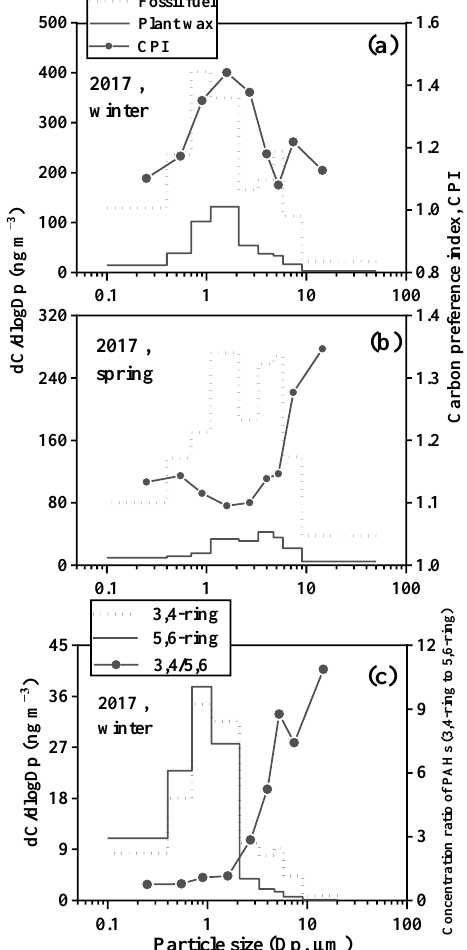
Figure 8. Particle size distributions of fossil fuel- and plant wax-derived n-alkanes and CPI values in Baoji (( a ). winter 2017; ( b ). spring 2017; ( c ). winter 2017). PAHs peaked at aerodynamic diameters of 0.7 µm < Dp < 1.1 µm in both 2008 and